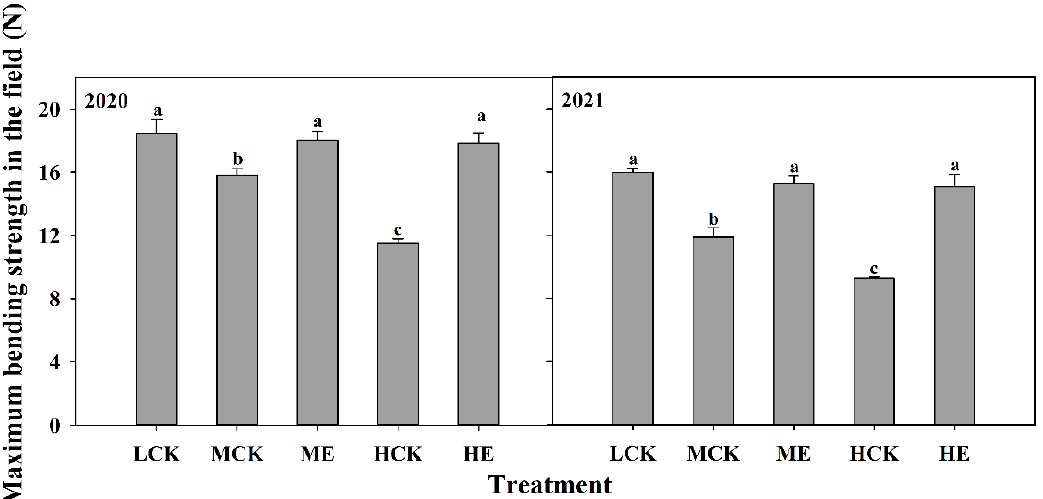
Figure 6. Effects of spraying ethephon on maximum bending strength in the field of summer maize. LCK, MCK, ME, HCK and HE were the treatments of low density control, medium density control, medium density sprayed with ethephon, high density control and high density sprayed with ethephon, respectively. Different lowercase letters in the figure indicated significant difference at 5% level.